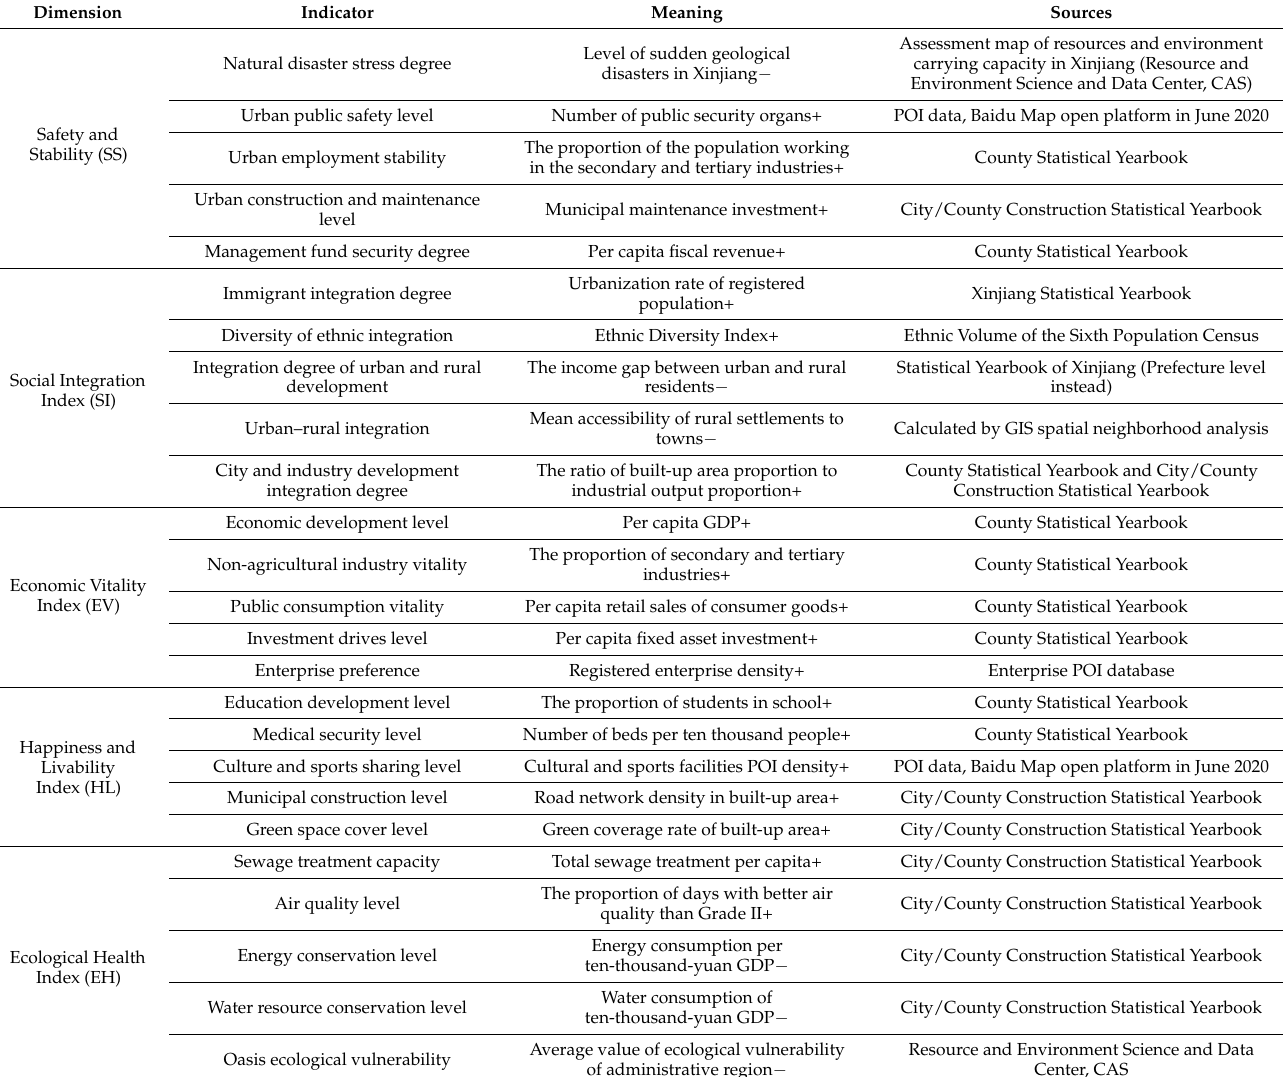
Table 1. Summary of evaluation index of urbanization sustainability in